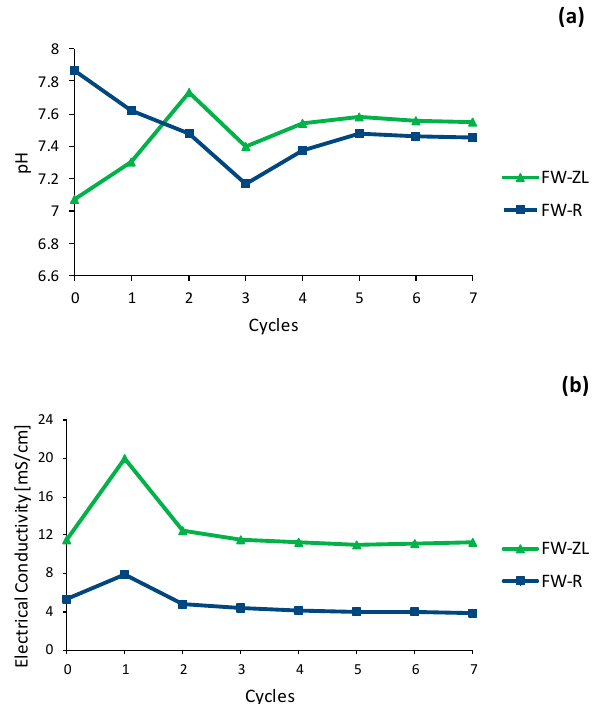
Figure 4. Variation of ( a ) pH and ( b ) electrical conductivity (mS/cm) of the leachates during the seven cycles of the batch test (FW–R: fine waste in the sludge from Redeyef and FW–ZL: fine waste in the sludge from M’Dhilla-Zone L).